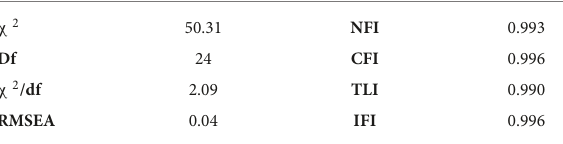
TABLE 5 Structural model of the current study.